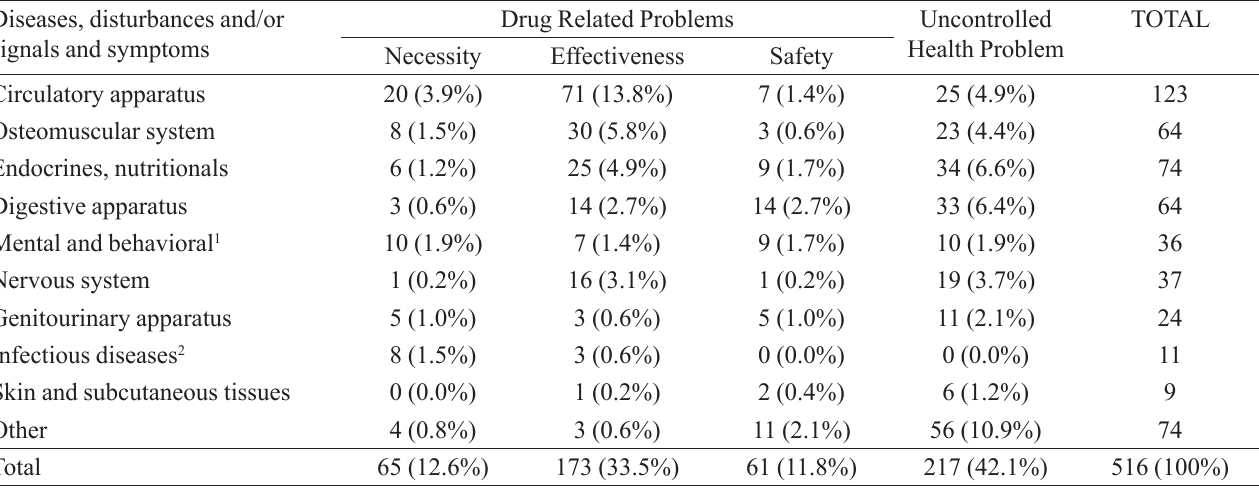
TABLE IV – Distribution of health problems, per category, presented by patients followed-up at FECUNP from 2001 to 2003 Diseases, disturbances